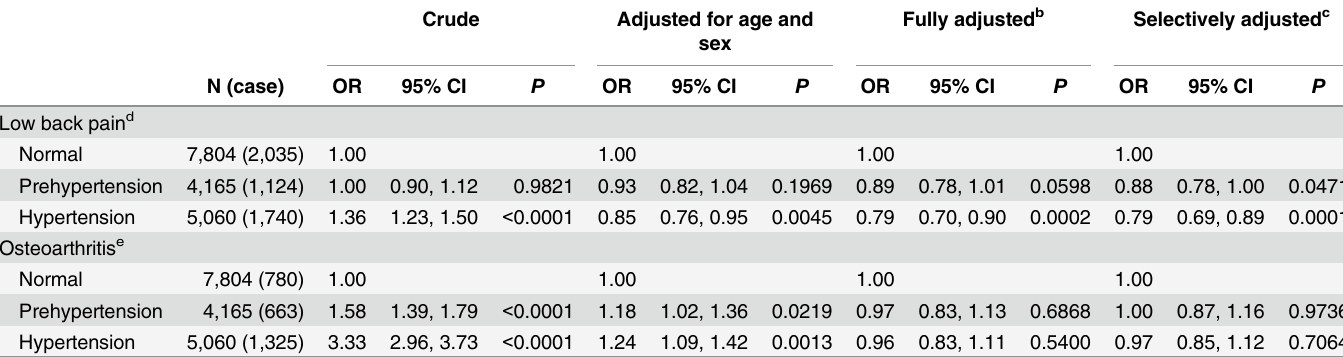
Table 2. Associations Between Blood Pressure Levels and Low Back Pain or Osteoarthritis in Korean Surveyees of KNHANES IV aged (cid:1) 20 years a . Crude Adjusted for age and